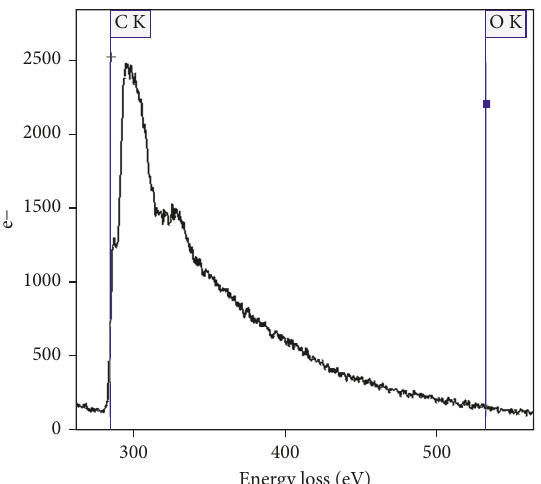
Figure 4: EEL spectrum of the Gr